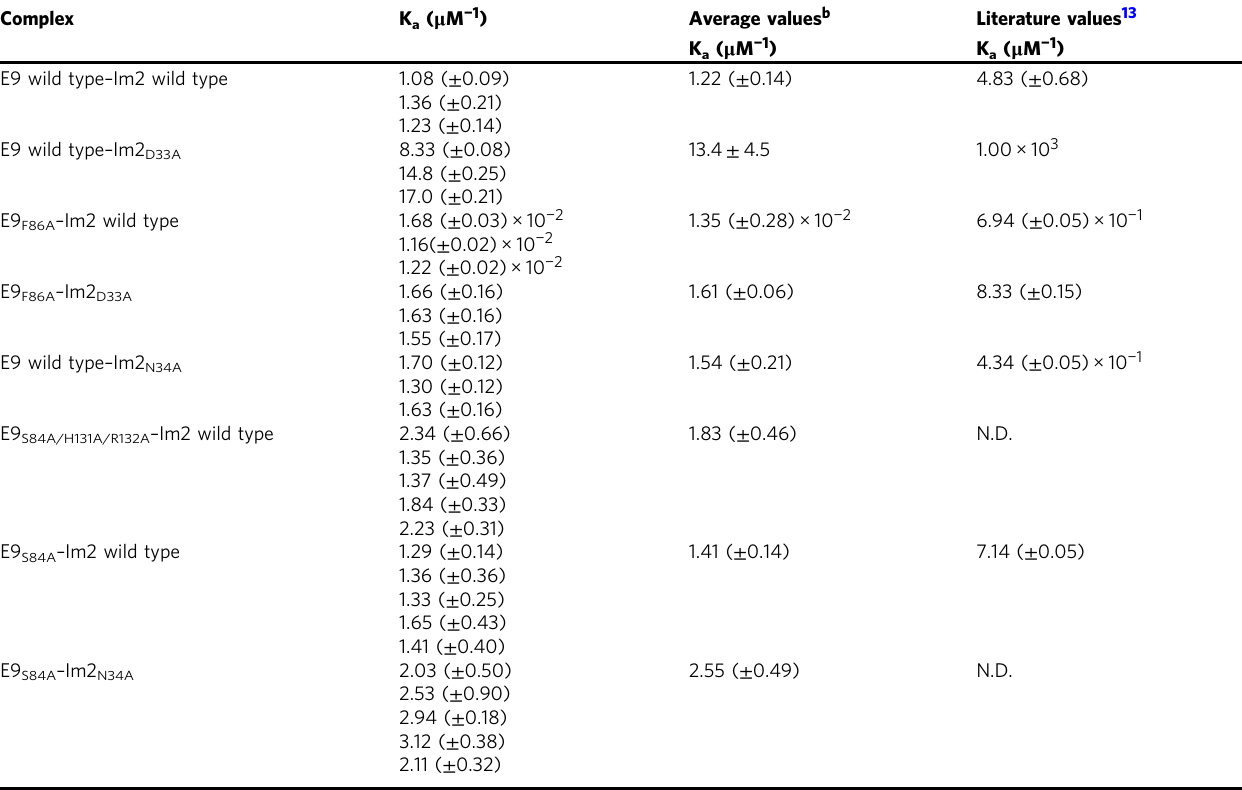
Table 1 Association constants for the interaction of E9 variants with Im2 variants determined by isothermal calorimetry a